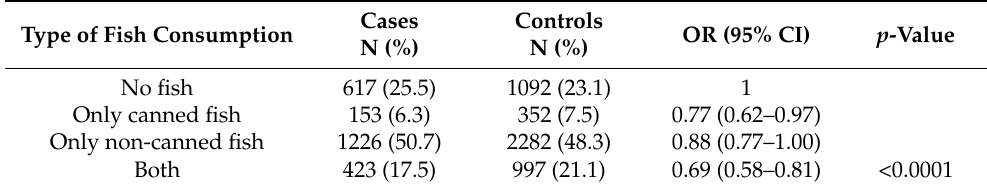
Table 3. Adjusted odds ratios * (ORs) and 95% confidence intervals (CIs) of risk of colorectal cancer according to consumption of different types of fish.